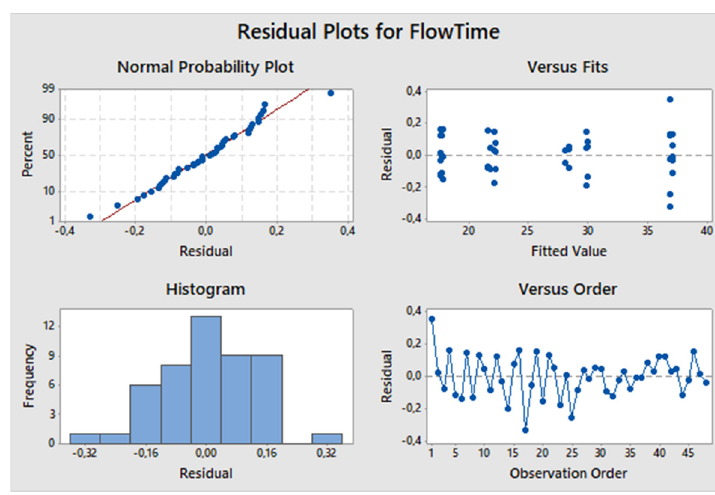
Figure 10. Residual Plots for Flow Time.